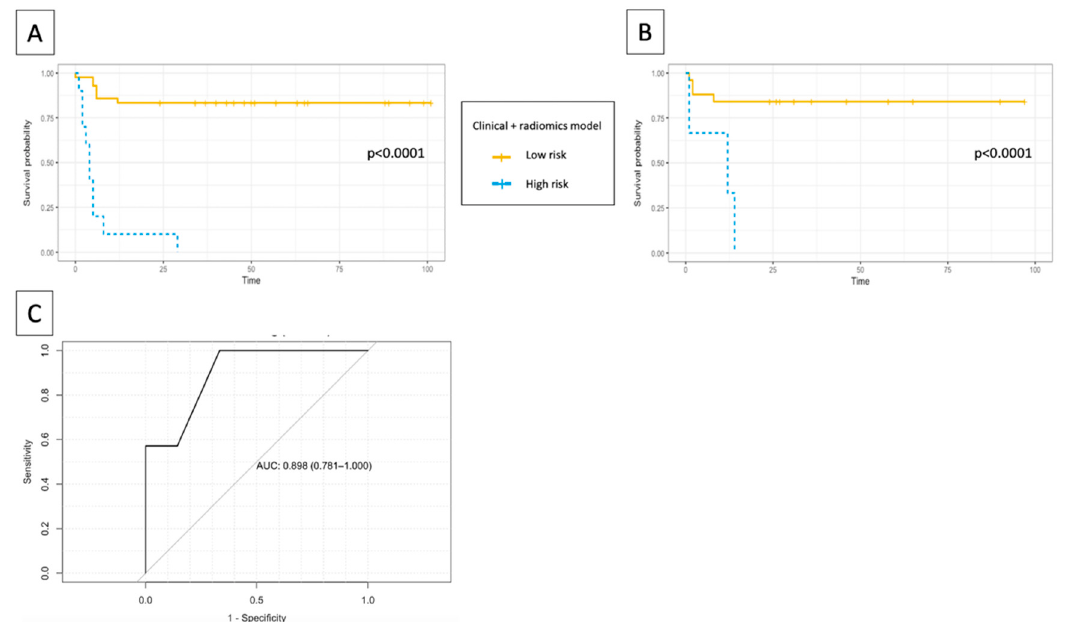
Figure 4. Kaplan–Meier estimates of disease-free survival using the combined (clinical and radiomics) model for ( A ) training and ( B ) testing set, and ROC curve in the testing set ( C ). Table 3. Correlation between variables and 2-year disease recurrence. (Abbreviations: Se = sensitivity, Sp = specificity).